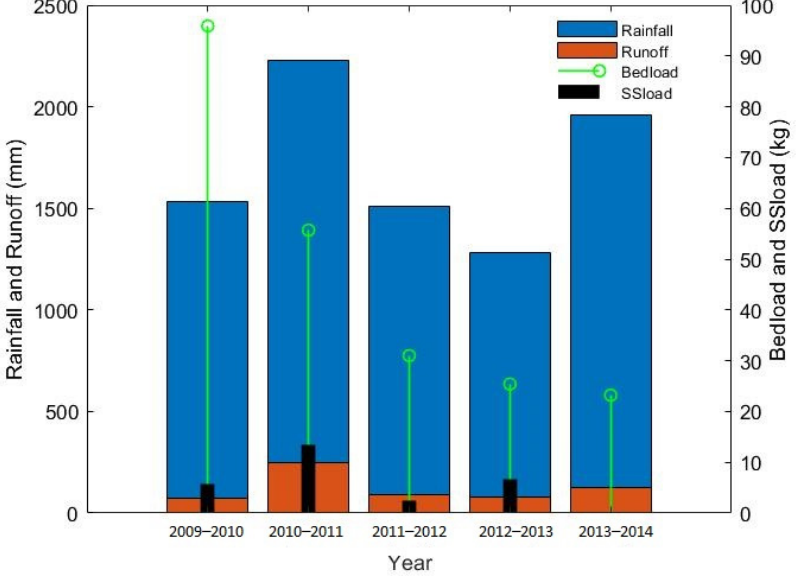
Figure 5. Annual distribution of the rainfall, runoff, bedload and suspended sediment load (SSload).